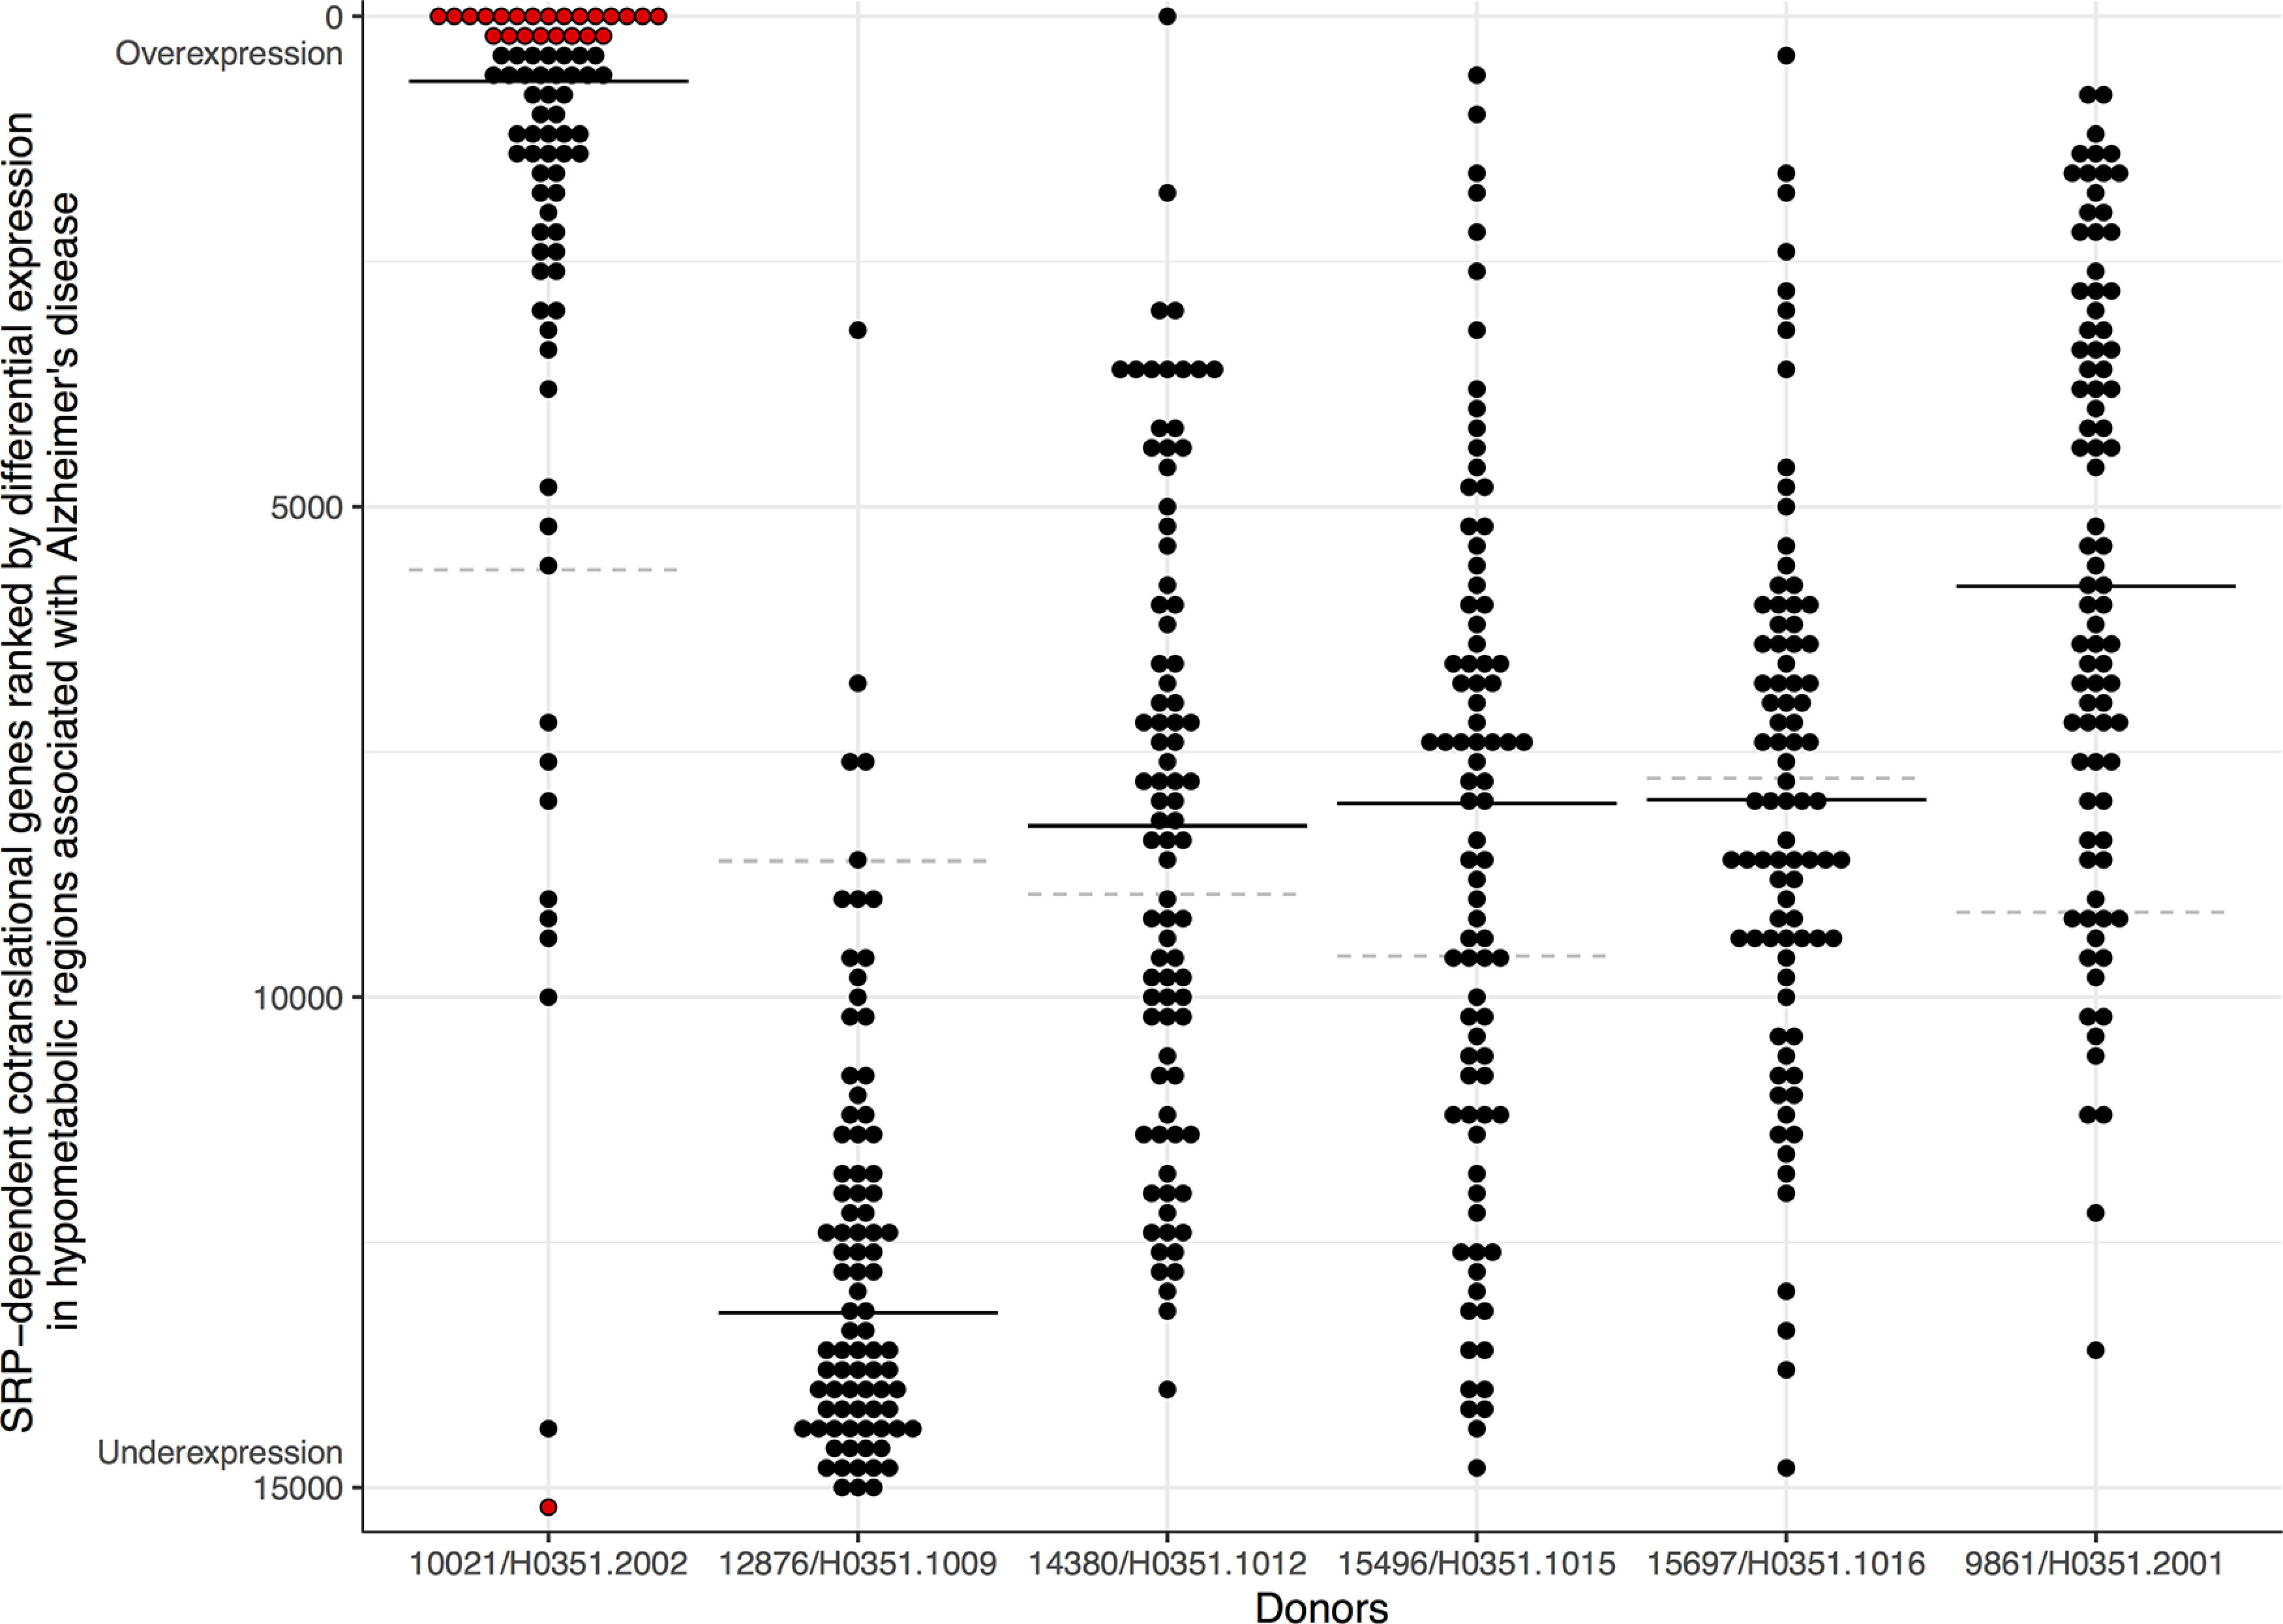
SRP-dependent cotranslational genes ranked based on differential expression in hypometabolic regions associated with AD. Genes are marked with dots, with the y-axis representing the genome-wide differential expression rank and ranges from overexpression (top) to underexpression (bottom). The black line marks the median expression rank of the SRP-dependent cotranslational genes. The dashed gray line marks the gene with the most stable expression between inside and outside of each donor’s hypometabolic regions. Red highlights genes that pass correction for multiple testing.